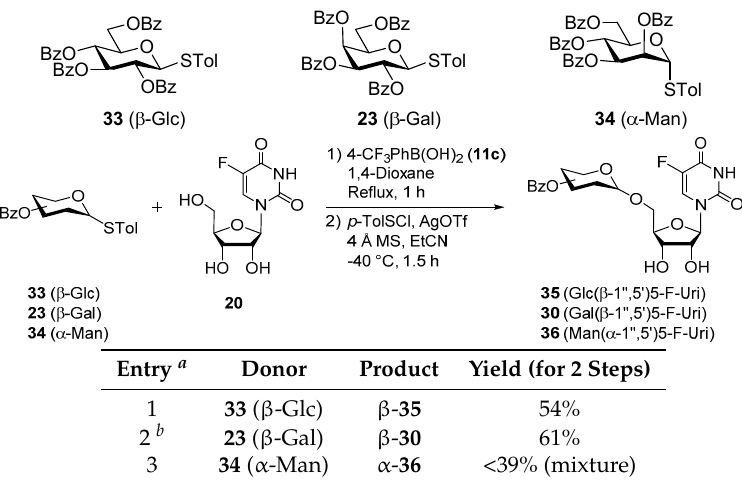
Table 4. O -Glycosylation of 5-fluorouridine 20 with thioglycosides 23 , 33 and 34 .